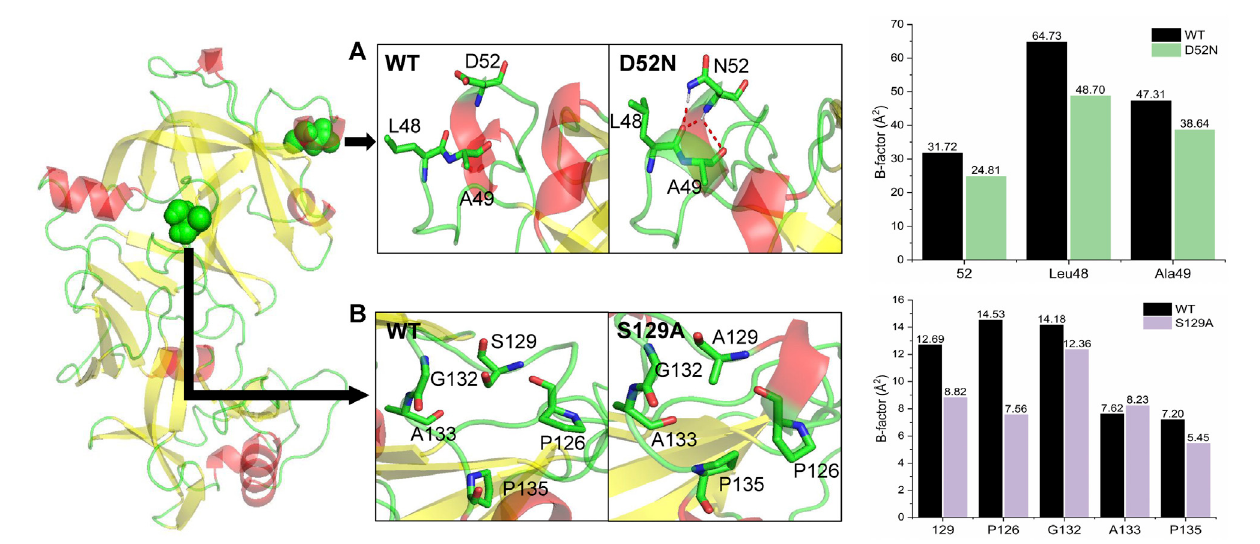
FIGURE 4 | Conformational analysis of wild-type (WT) and mutant pepsin. (A) Mutant D52N formed new hydrogen bonds with Leu48 and Ala49. The B-factors of theseresidues decreased compared withthewild-type. (B) Mutant S129A promotedhydrophobicpacking in theloop.The B-factors ofmostthese residues decreased compared with the